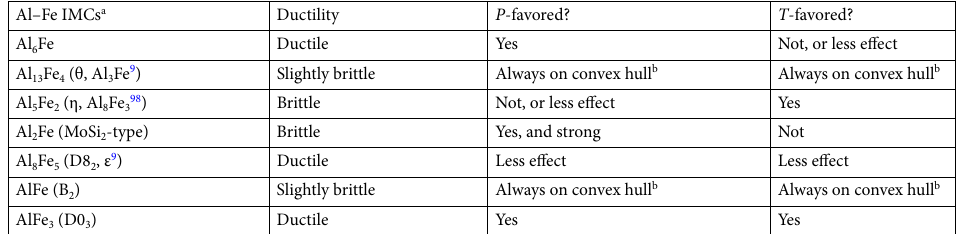
Table 2. Summary of phase stability of key Al–Fe IMCs with respect to pressure ( P ) and temperature ( T ) shown in Figs. 1, 3, and 5 (or not shown); together with their ductility/brittleness according to Pugh’s criterion 11,12 as shown in Fig. 2. a Names used in the present work together with the names in the parentheses used in the literature. b These IMCs are always stable and on the convex hull in the present P and T of studied.